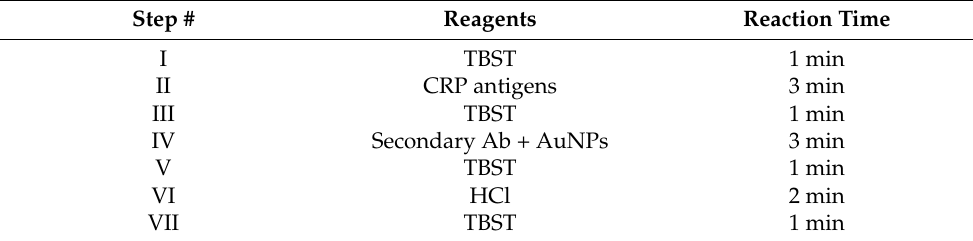
Table 3. Measurement